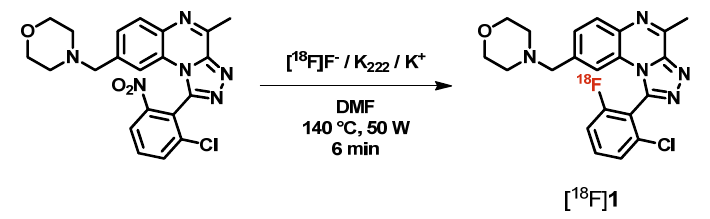
Figure 1. Molecular structures of 18 F-labeled PDE2A inhibitors for PET. Figure 1.